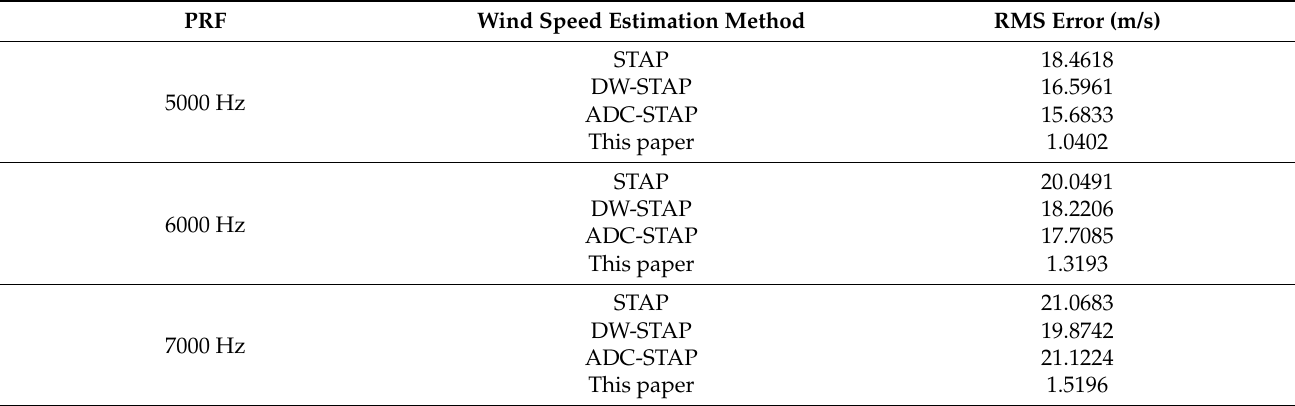
Table 3. Comparison of root-mean-square error of wind speed estimation results under different PRF